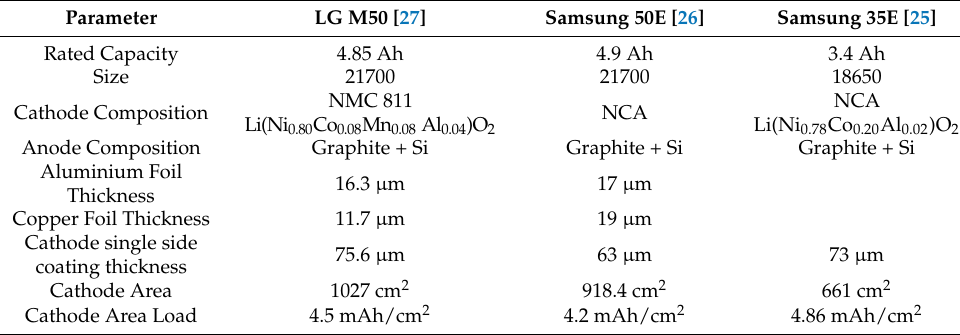
Table 2. Structure and composition of the investigated high-energy cells.